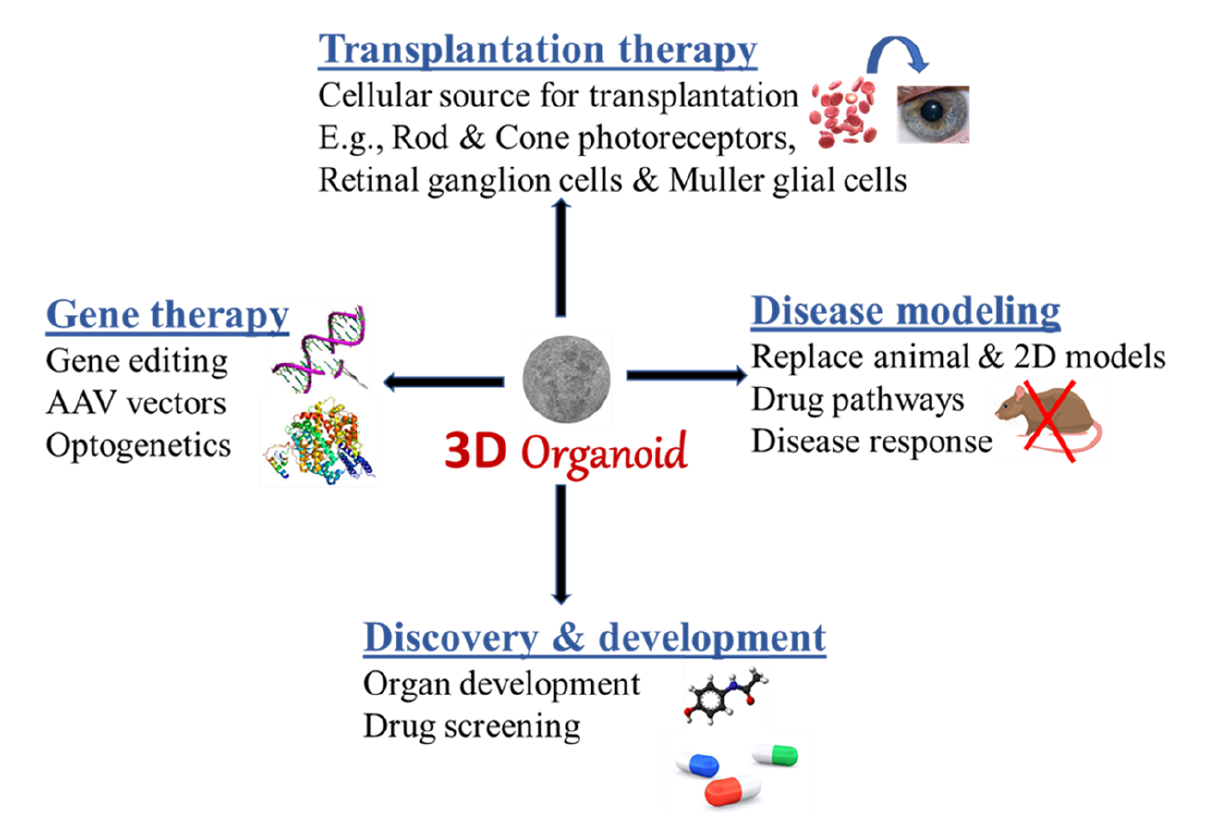
Figure 1. Schematic summary of applications of brain and retinal organoids derived from human pluripotent stem cells.